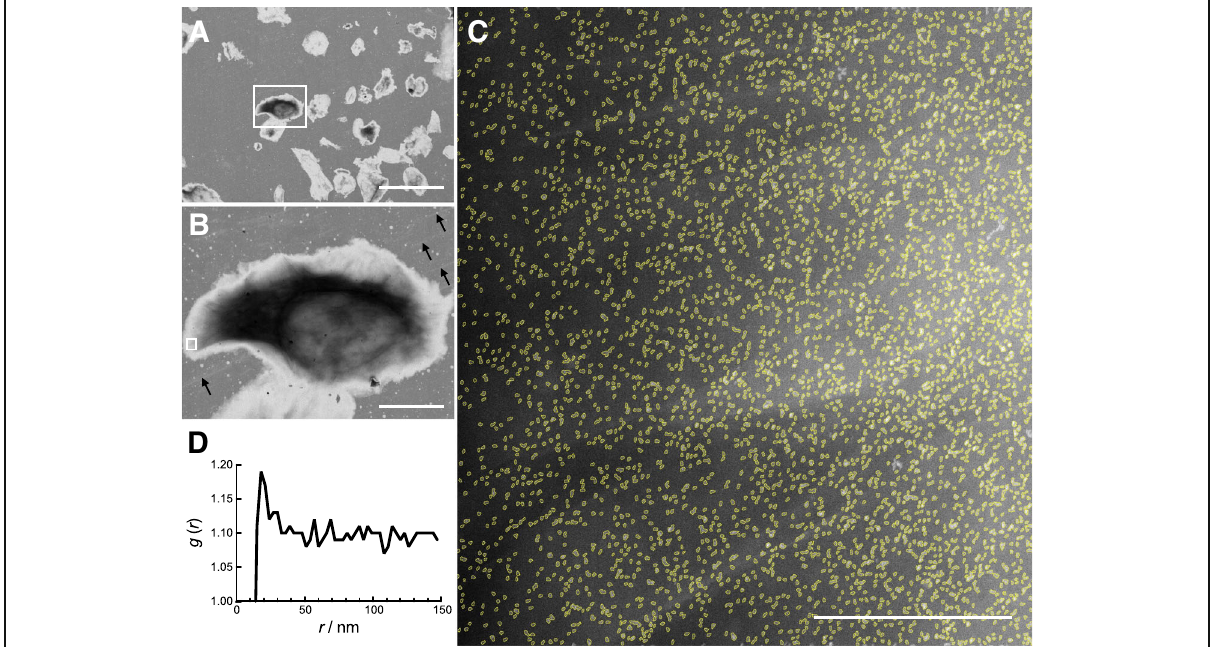
Fig. 4 Scanning transmission electron microscopy (STEM) images of the same sample shown in Fig. 3a and c, after an additional fixation step with glutaraldehyde, and coating with multilayer graphene, keeping the cells in hydrated state inside the electron microscope. a Low magnification (800 x) overview STEM image of the same region as shown in Fig. 3c used to navigation to the regions of interest. b Low magnification (4000 x) overview STEM image of the boxed cell in a , the same as shown in Fig. 3c. The multilayer graphene sheet, covering the whole sample, was invisible, except for some faint, bright, linear structures, representing fine folds in the graphene (see arrows). c STEM image (120,000 x magnification) recorded at the boxed region in B revealing the abundance of labelled HER2 on the cancer cell. The electron-dense QD labels were automatically detected and outlined in yellow to enhance their visibility. d The pair correlation function g ( r ) measuring the probability of a certain inter-label distance r calculated for the labels shown in c . The peak at ~ 20 nm indicates the presence of HER2 homodimers. Scale bars, in a : 50 μ m, in b : 10 μ m, and in c : 500